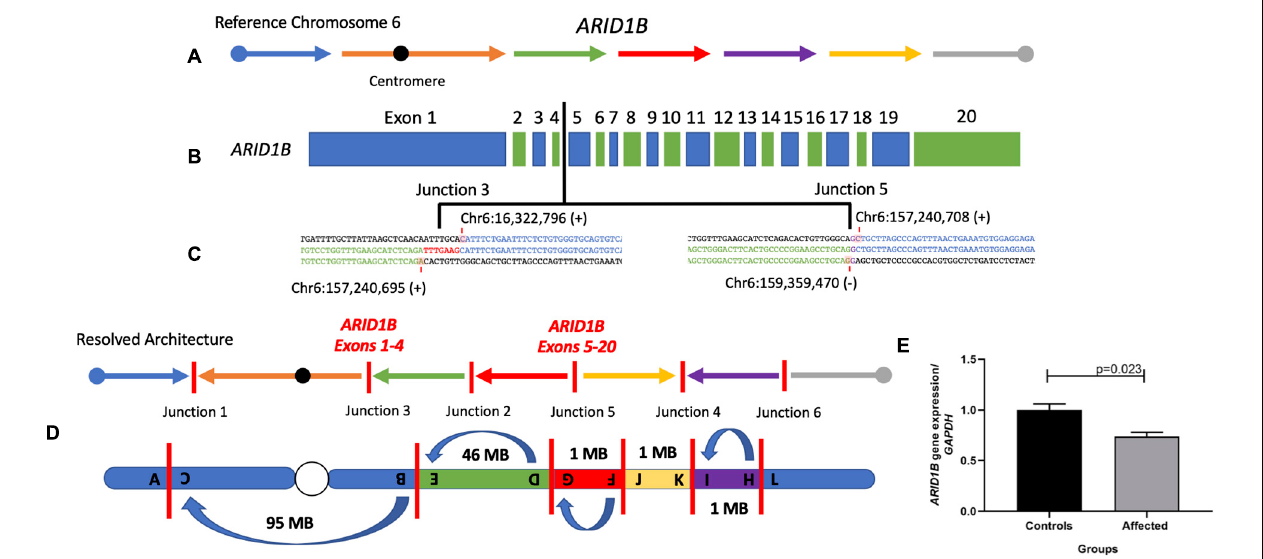
FIGURE 3 | Final chromosome 6 resolved architecture revealed disruption of the gene ARID1B . (A) Structure of chromosome 6 displaying the reference orientation of each genomic fragment as represented by arrows moving from left to right with the centromere positioned as a black circle. (B) Coding structure of the gene ARID1B (NM_001374820.1). Vertical black line indicates the inversion break that disrupted the gene between the fourth and fifth exons. (C) Breakpoint sequence alignments of junctions 3 and 5 indicate the nucleotide positions disrupted within ARID1B . (D) Final resolved structure of chromosome 6 showing six breakpoint junctions with one pericentric inversion and three paracentric inversions on the q arm. (E) qPCR analysis of ARID1B mRNA in patient compared to three controls reveal significant expression reduction ( ∼ 30%) in peripheral blood.